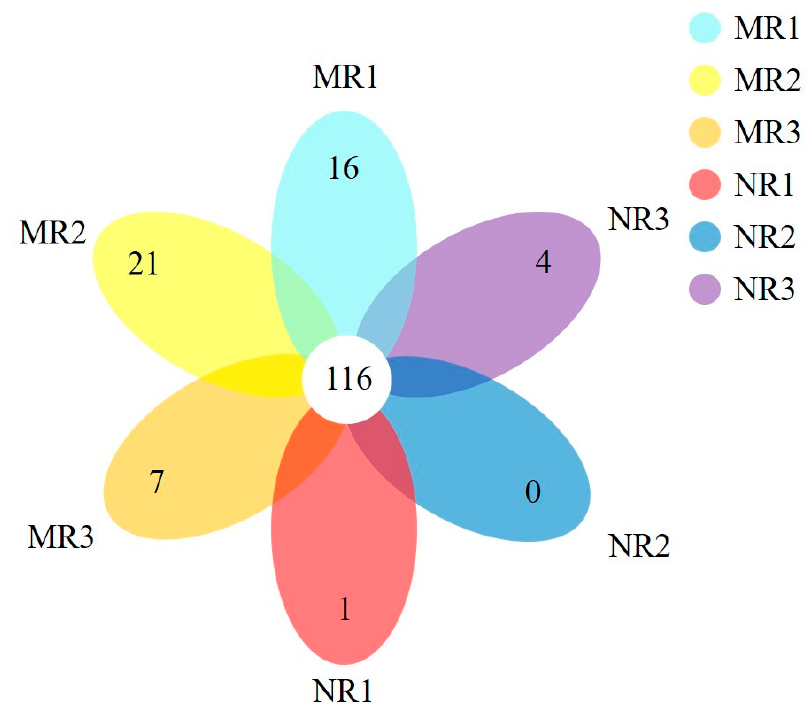
Figure 3. Venn diagram of bacteria. Each color in the Venn diagram represents a sample. Overlapping circles represent the number of OTUs shared by the sample; non-overlapping sections represent the number of OTUs specific to the sample.